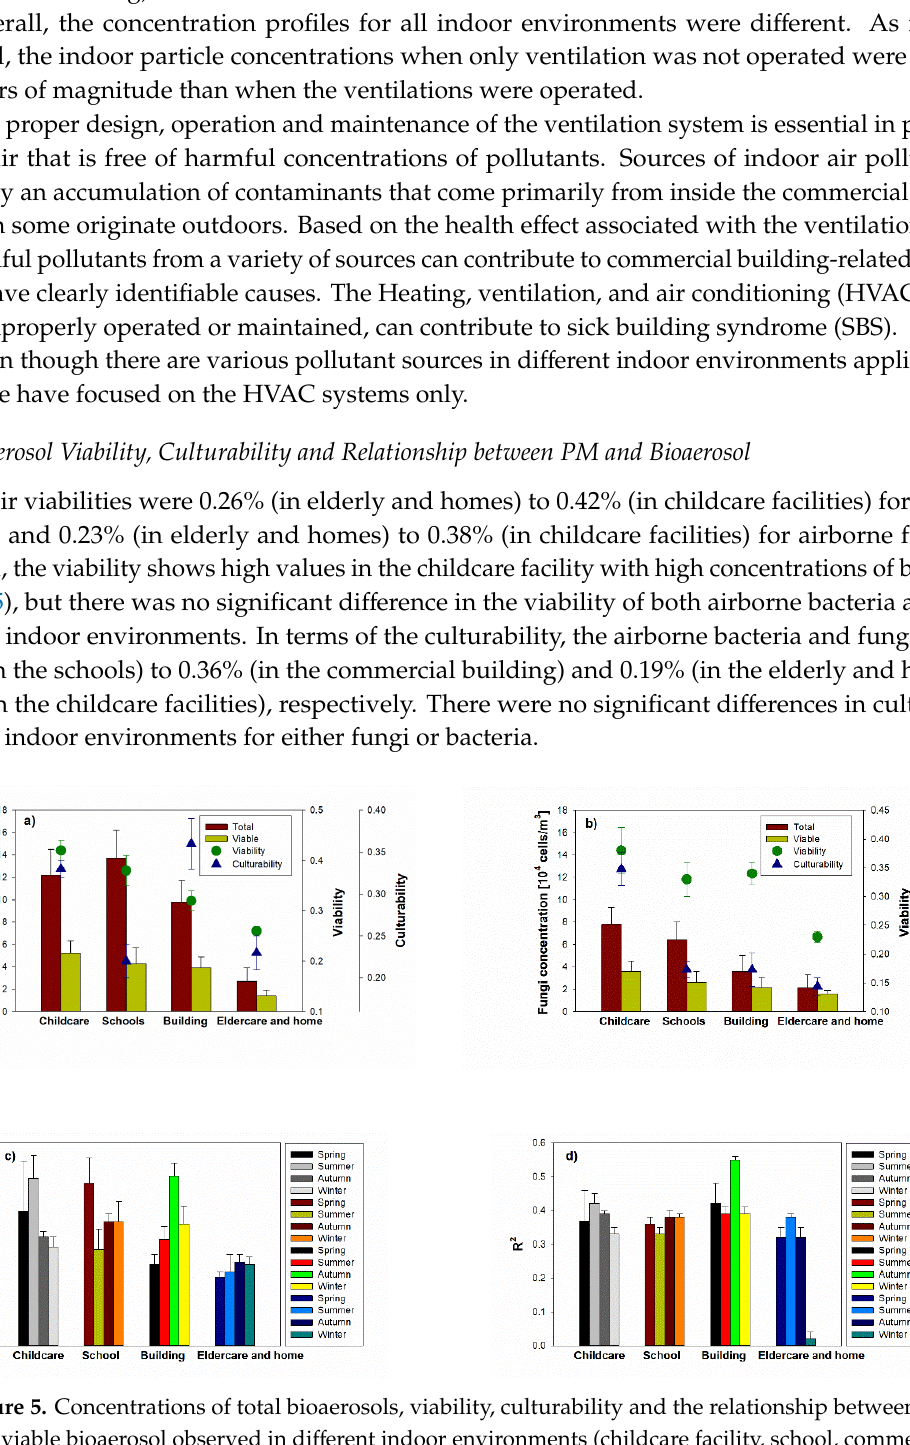
Figure 4. Size distributions of indoor particles in different places (childcare, school, commercial building, elderly facility and homes) and their variation with time as a function of ventilation. The data present averages of three repeats. count concentrations ranged from 1.6 particles / cm 3 (childcare facility) to 3.8 × 10 2 particles / cm 3